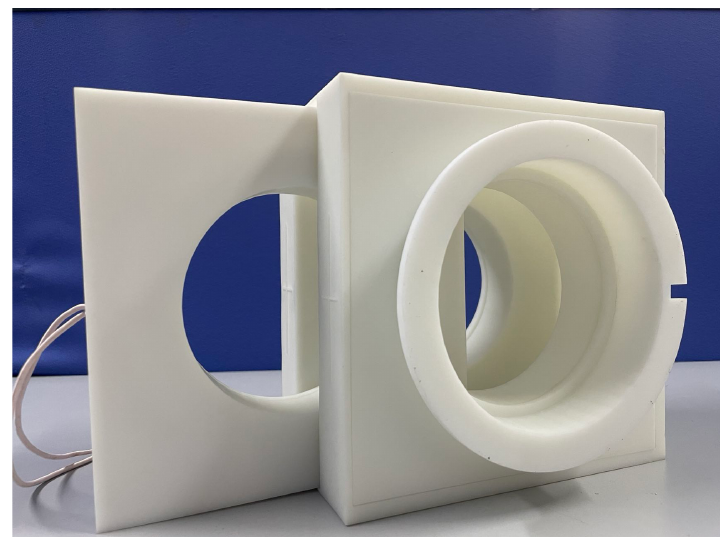
Figure 12. Semi-enclosed housing structure diagram.